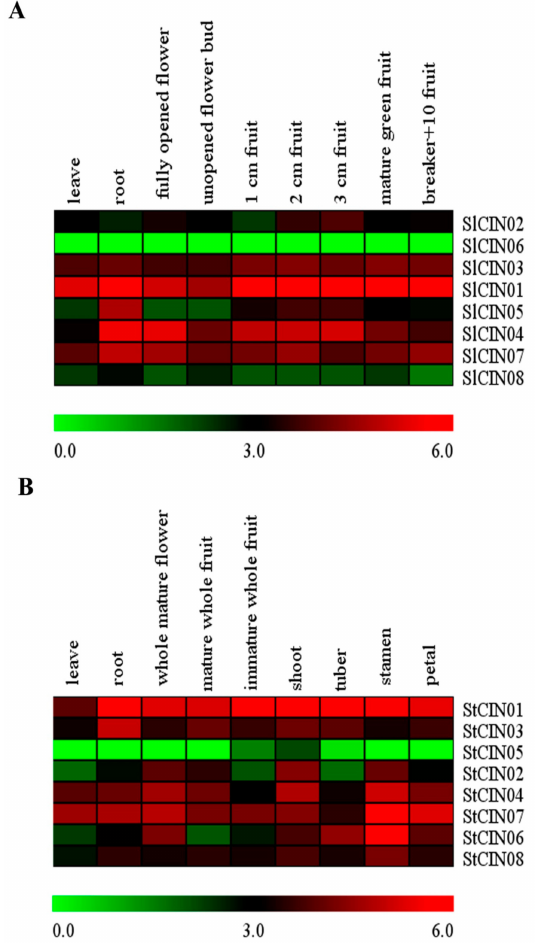
Figure 8. Heat map of expression profiles of CIN genes in various stages or tissue types of ( A ) S. lycopersicum and ( B ) S. tuberosum . ( A ) Tested tissue types were leaves, roots, fully